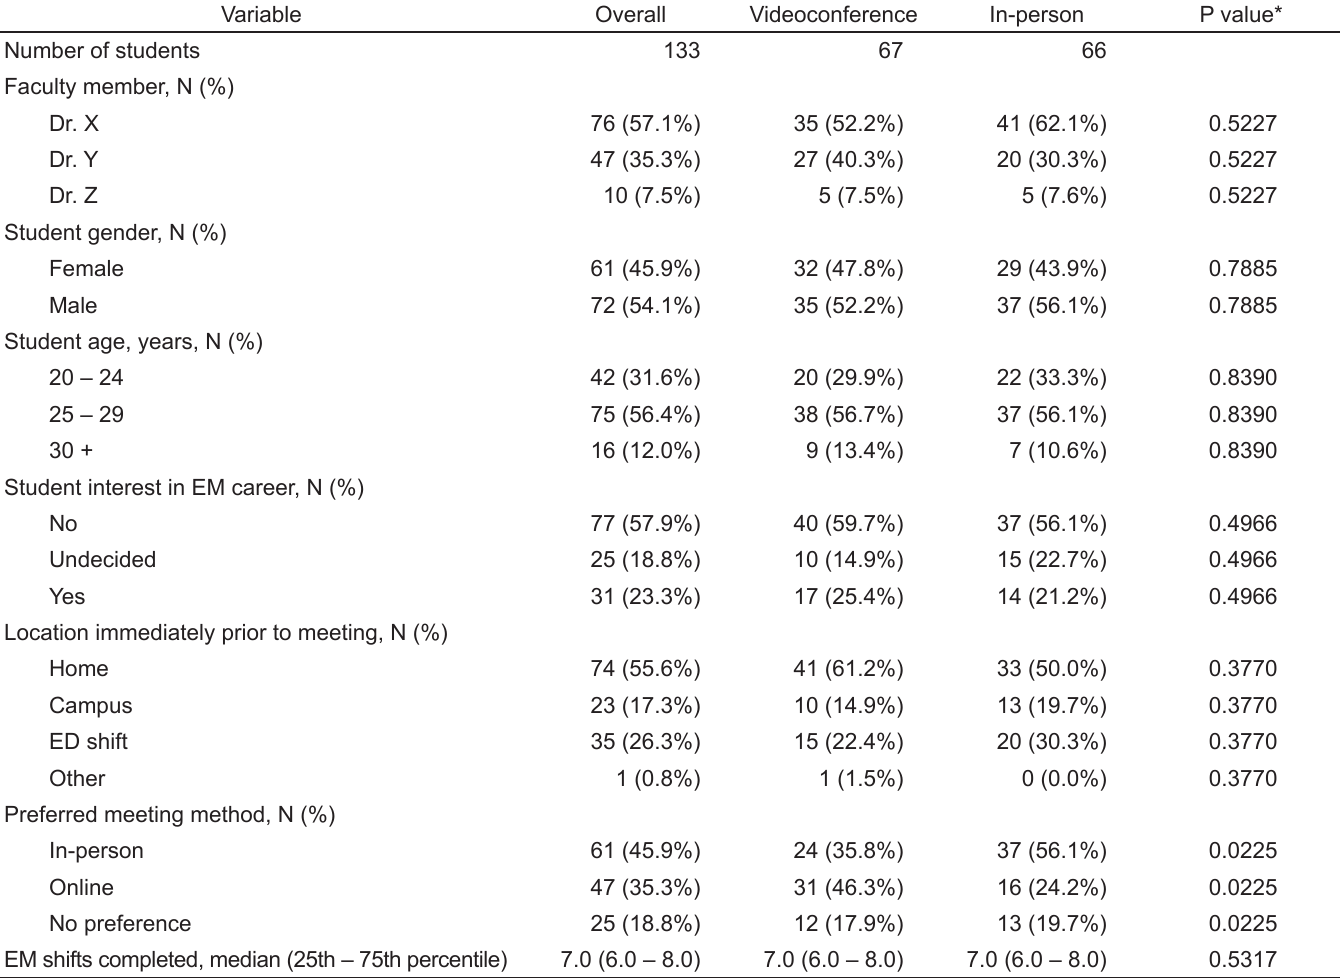
Table 1. Analyses of study participants’ demographic variables comparing individuals meeting via videoconference vs. in-person for their mid-clerkship feedback sessions.